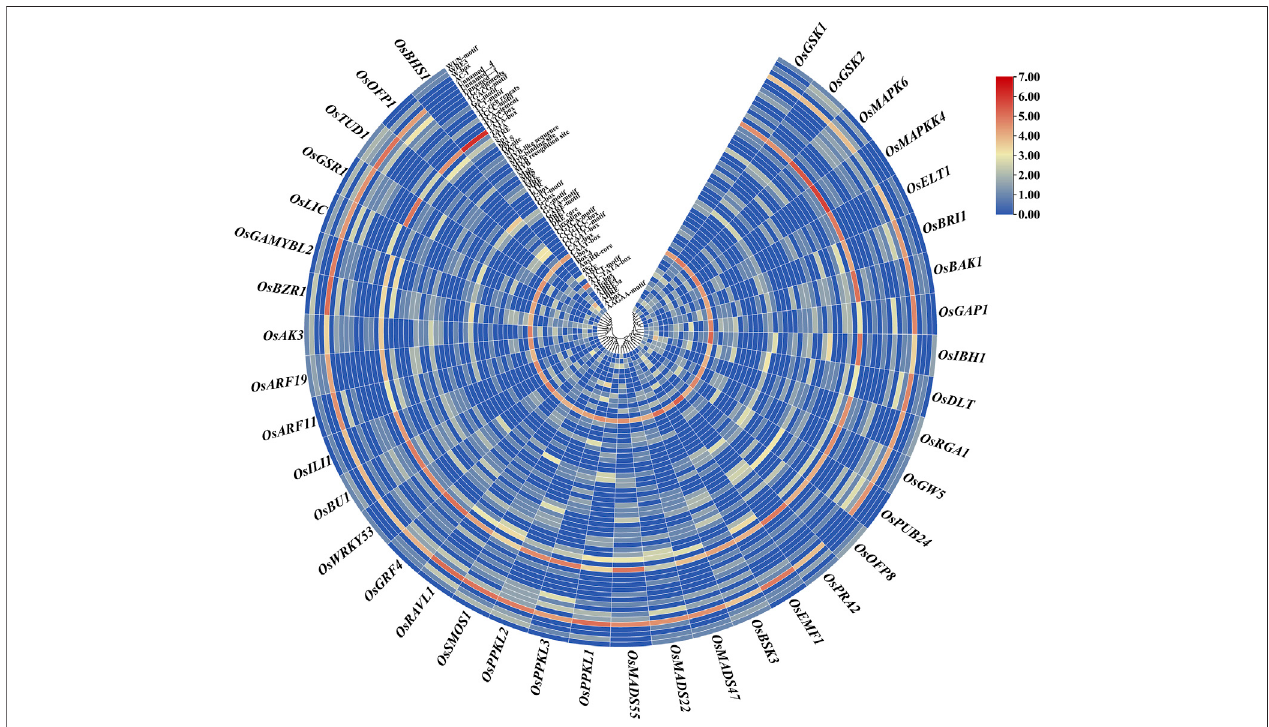
FIGURE 4 | A graphical representation of commonly present cis-regulatory elements in 1.5-kb upstream promoter sequences of the 39 BR signaling genes in O. sativa. Abbreviations/Functions: ABRE: ABA-responsive element; ERE: Ethylene-responsive element; ARE: Anaerobic response element; LTR: Low temperature- responsive element; STRE: stress-responsive element; MRE: Myb-related element: DRE: dehydration-responsive element; GARE: thymine- and cytosine-rich repeats.